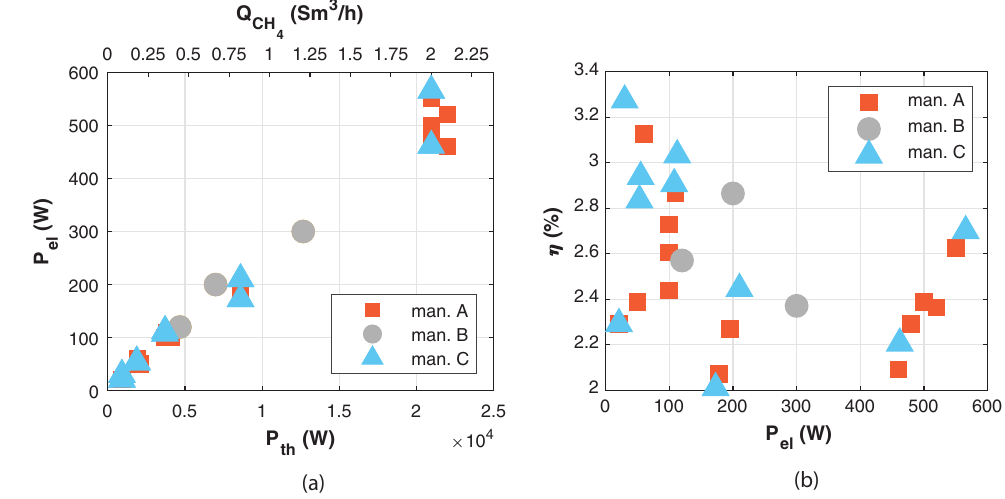
Figure 1. Power levels ( a ) and nominal efficiencies ( b ) of